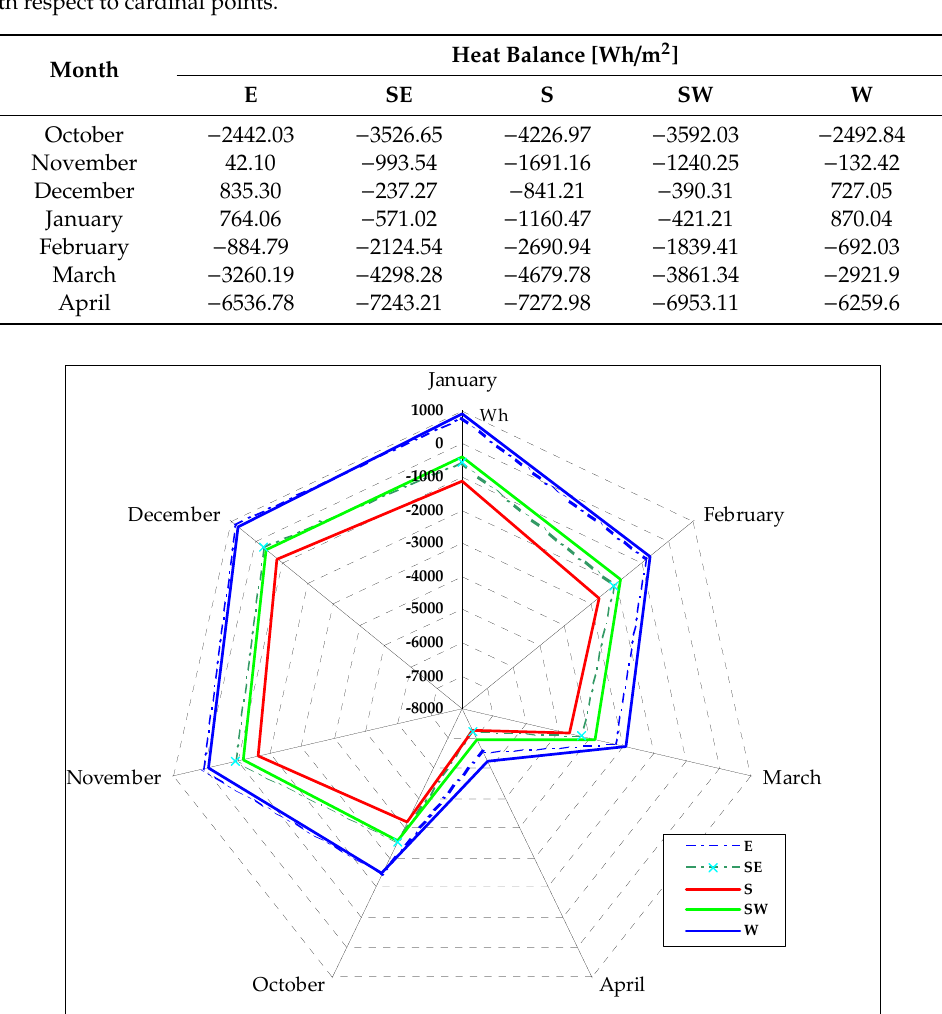
Figure 11. Heat balance calculated for the months of the heating season depending on the orientation with respect to cardinal points chart.